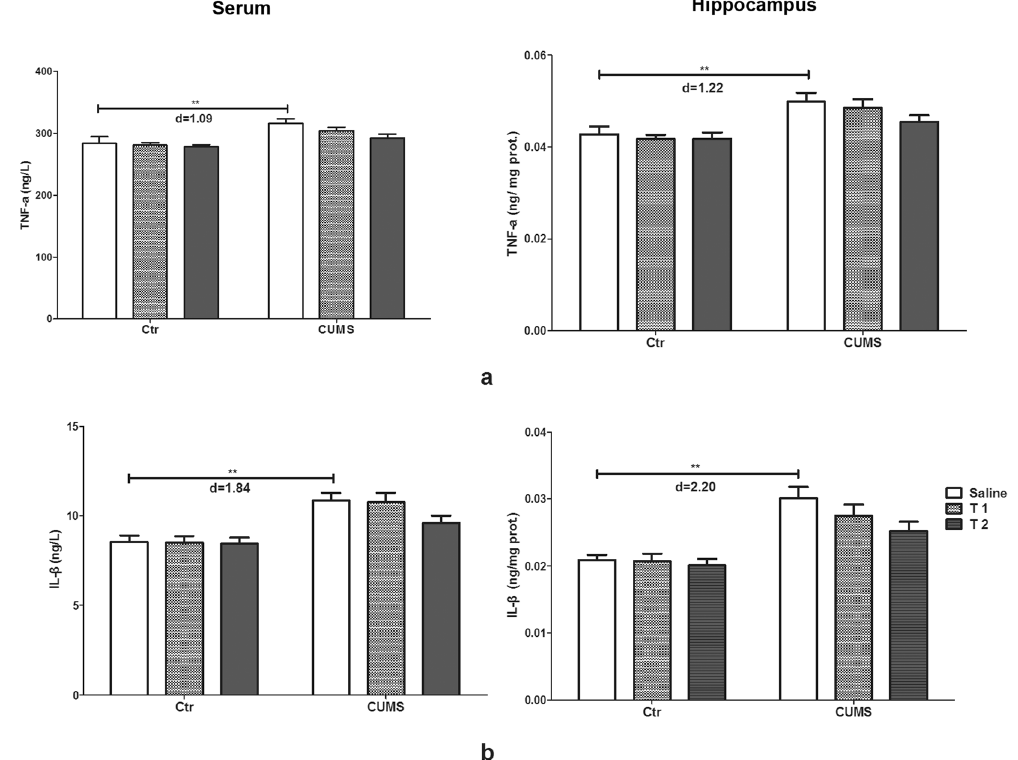
Figure 6. Effects of taurine on the concentrations of cytokines. ( a ) Concentrations of TNF- α in the serum and hippocampus. ( b ) Concentrations of IL-1 β in the serum and hippocampus. Ctr, control group; CUMS, CUMS group; Saline, i.p. saline; T1, i.p. 200 mg/kg taurine; T2, i.p. 500 mg/kg taurine; All data are expressed as means ± SE and were analyzed by two-way ANOVA followed by Bonferroni’s multiple comparisons post hoc test (n = 10). * P < 0.003 vs. CUMS group; ** P < 0.00067 vs. CUMS group. d means Cohen’s d, d = 0.20